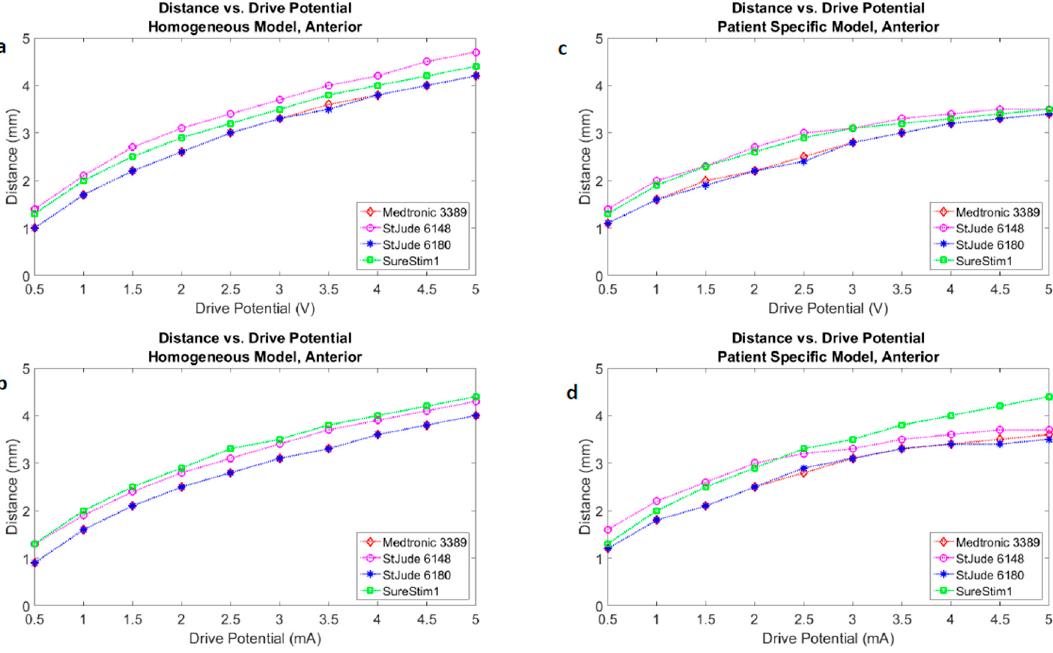
Figure A1. Neuron modelling: Distance vs. drive potential. Anterior.